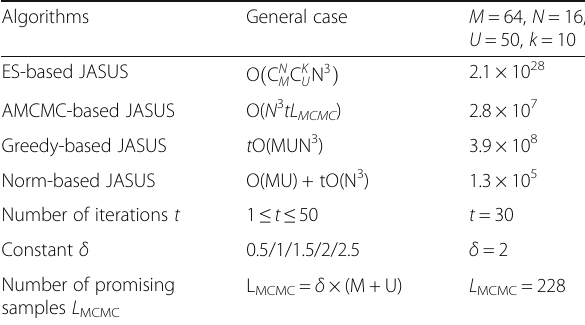
Table 2 Computational complexity analysis